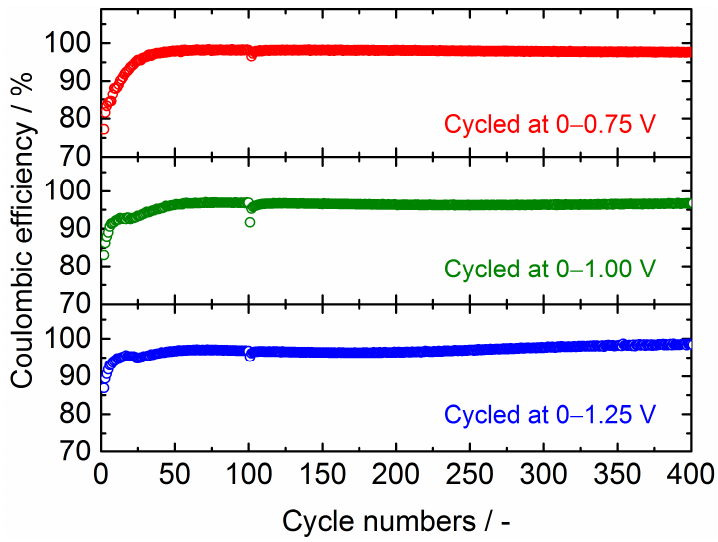
Figure 12. Coulombic efficiencies plotted against the cycle numbers for Sn 4 P 3 /C composite films tested at different cell voltage windows.